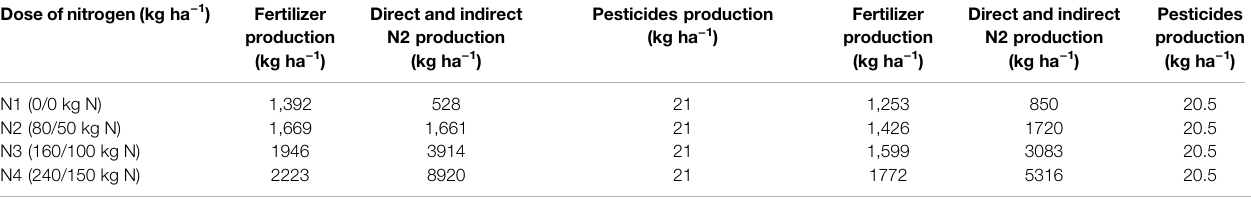
TABLE 3 | Response of various level of nitrogen application on GHG emission (kg ha − 1 ) from various sources of farm (maize-wheat cropping system).